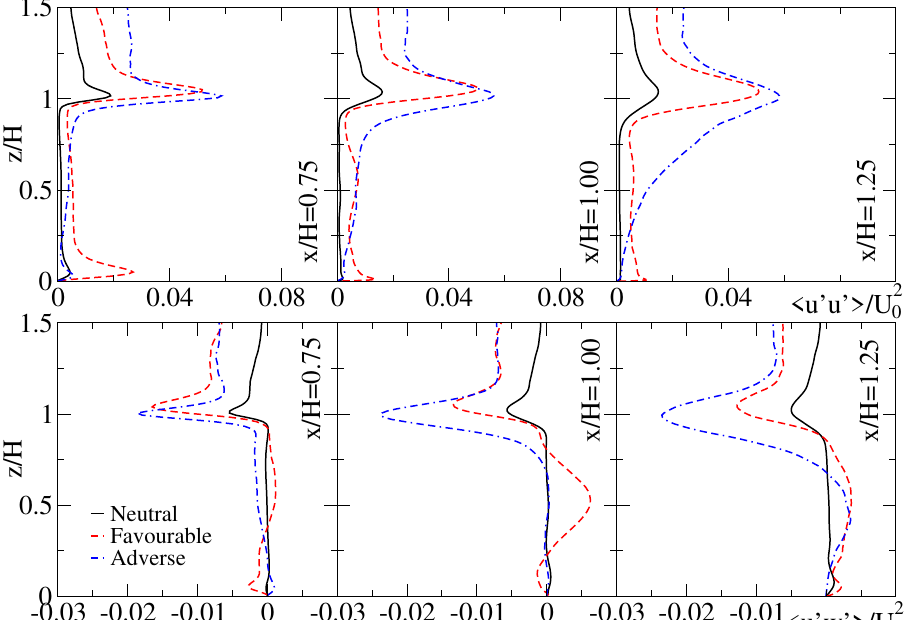
Figure 8. Resolved Reynolds stress component in streamwise direction (cid:104) u (cid:48) u (cid:48) (cid:105) and turbulent kinematic momentum fluxes (cid:104) u (cid:48) w (cid:48) (cid:105) , averaged and made non-dimensional through U 0 . Profiles along three selected vertical lines x / H =